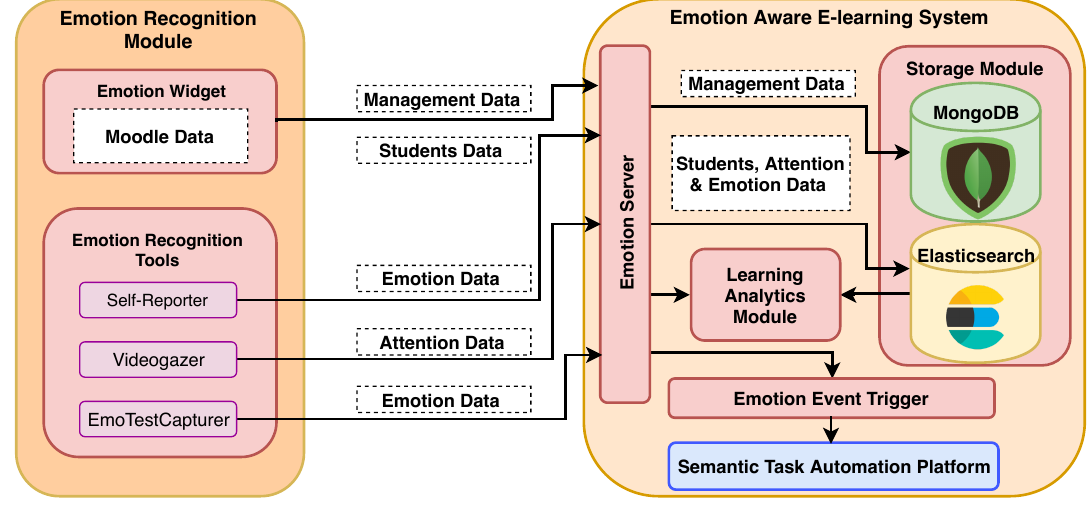
Figure 2. Emotion aware e-learning module flow